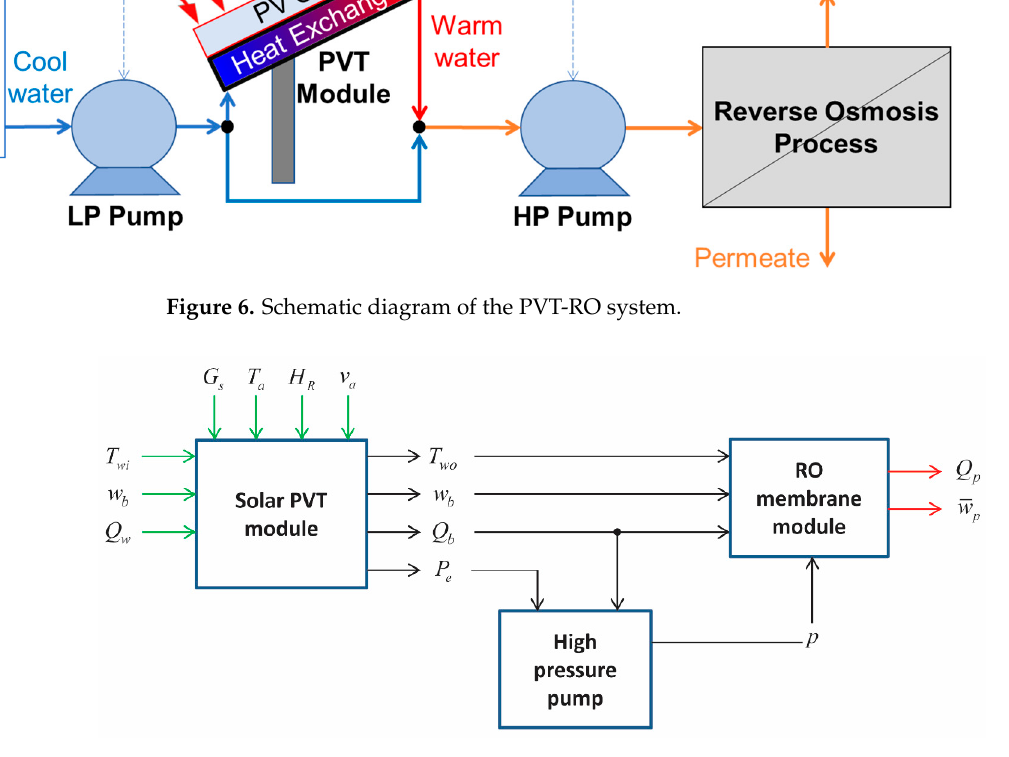
Figure 7. Variable map and block diagram of the mathematical model of the PVT-RO system, where green arrows are inputs, black arrows are intermediate variables, and red arrows are outputs. Refer to the nomenclature for variable descriptions.